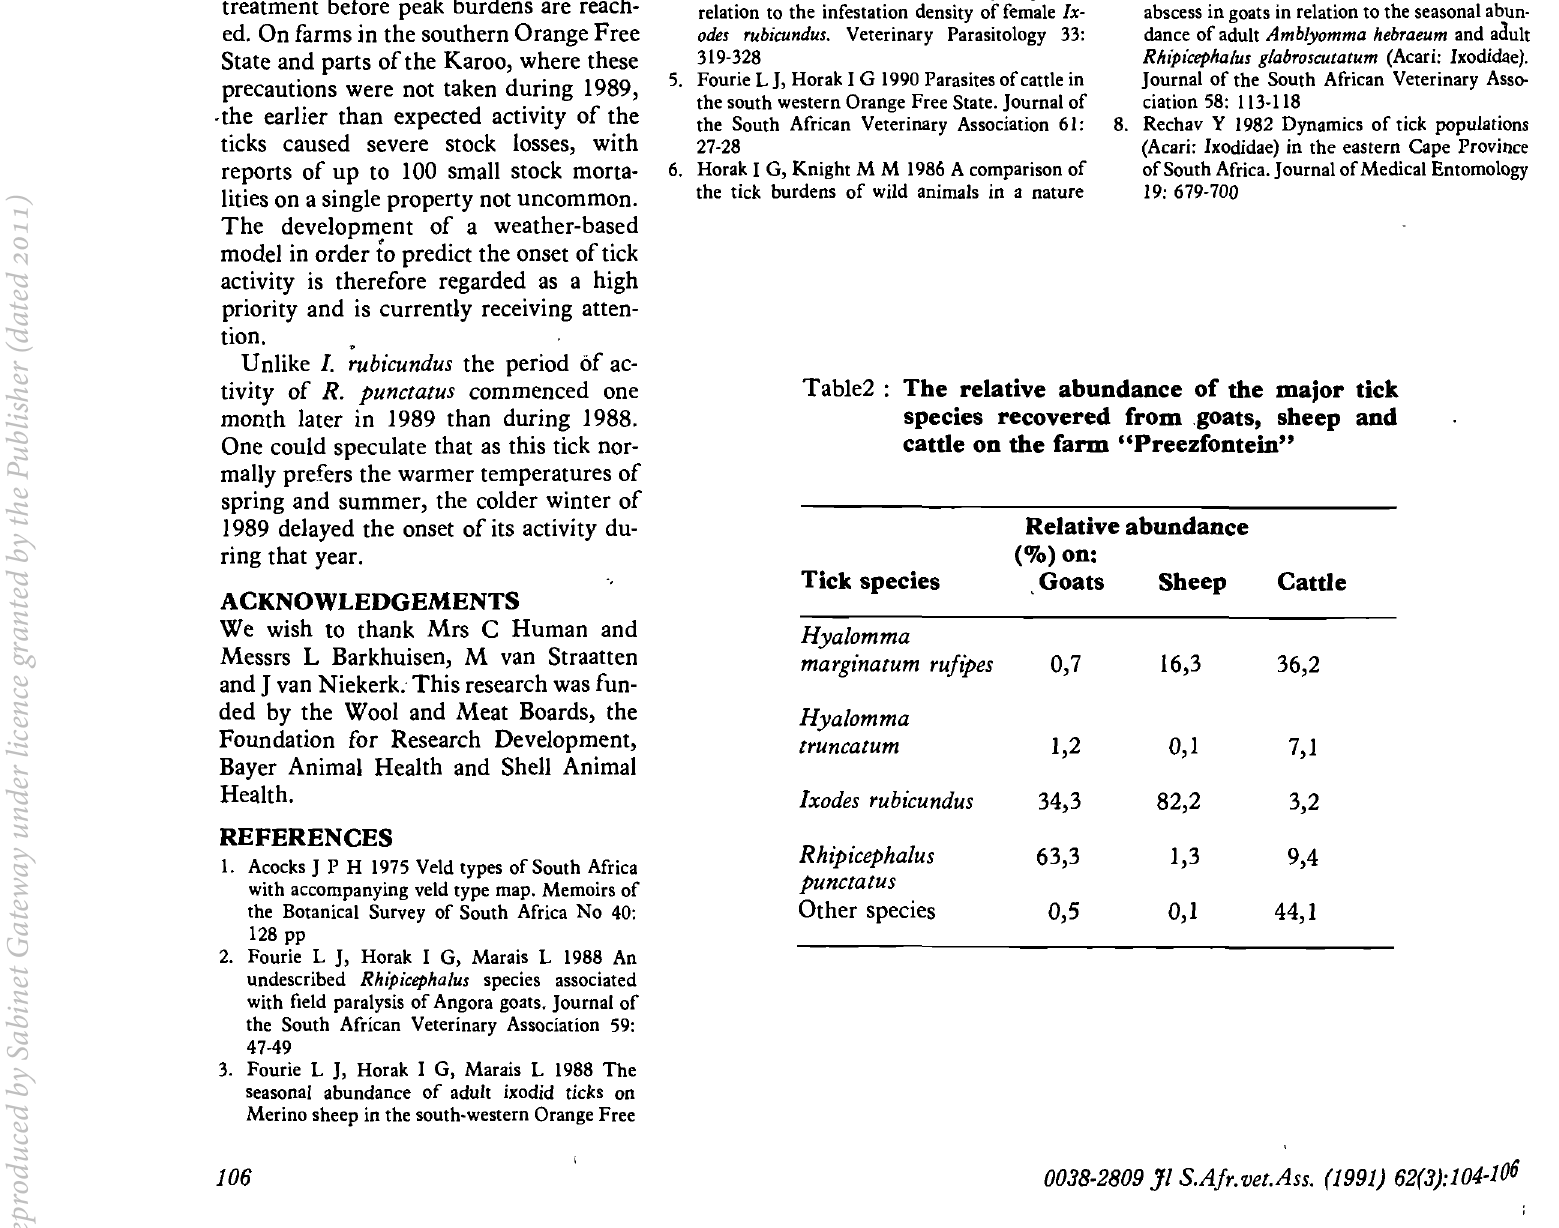
Fig. 4: The seasonal abundance of adult Fig. 3: The seasonal abundance of adult Ixodes Rhipicephalus punctatus on Angora goats on rubicundus on Angora goats on the farm the farm "Pree:zfontein" in the south western "Preezfontein" in the south western Orange = Orange Free State (infestation density Free State (infestation 'density number of number of ticks per kg host body mass) ticks per kg host body mass)